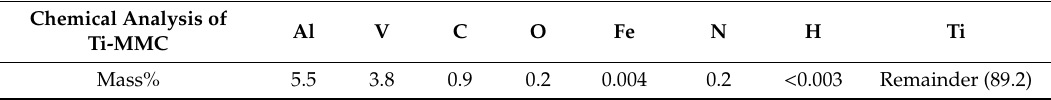
Table 2. Elemental composition of titanium metal matrix composites (Ti-MMCs)